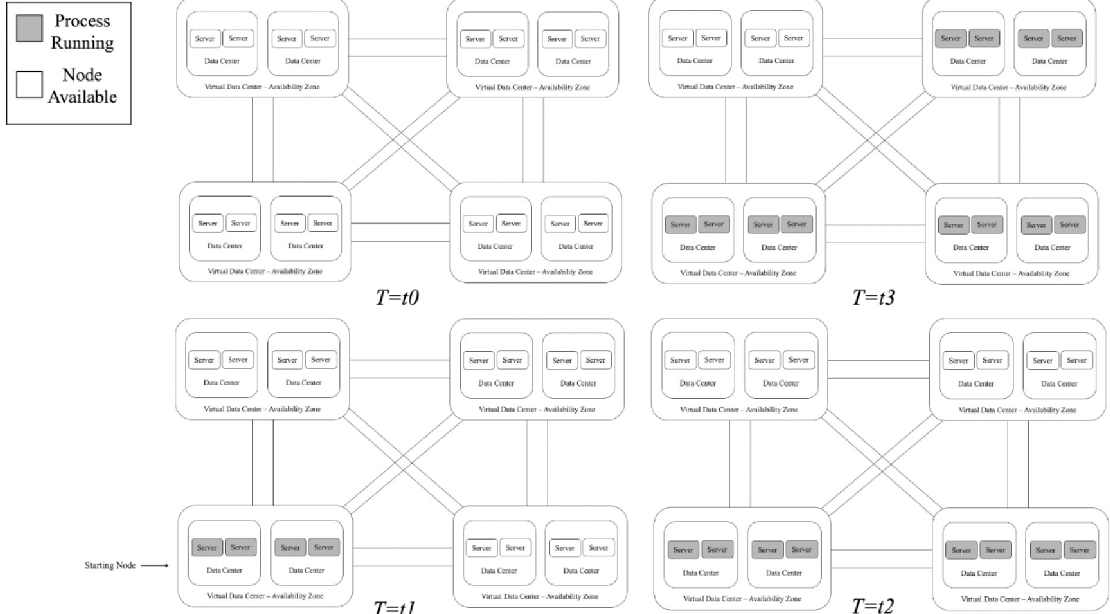
Fig 2. Computing provider’s distributed over a network of machines with the respective published service’s and available nodes.